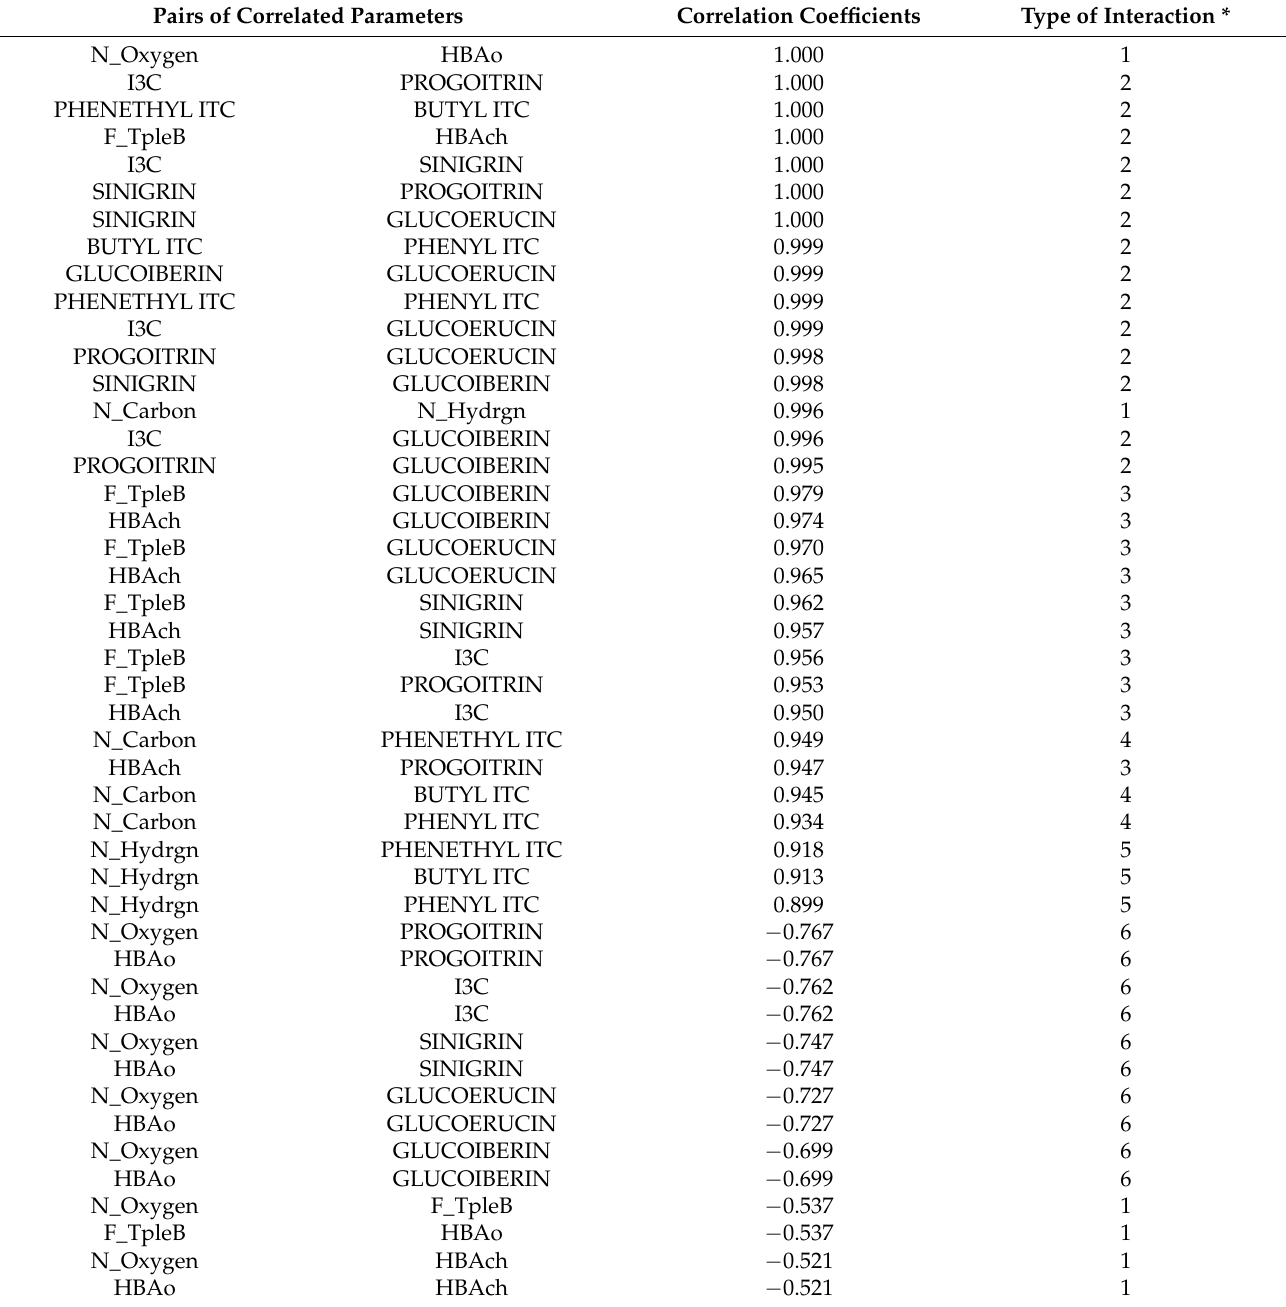
Table 1. Correlation coefficients for the pairs of parameters based on first two latent components of the PLS